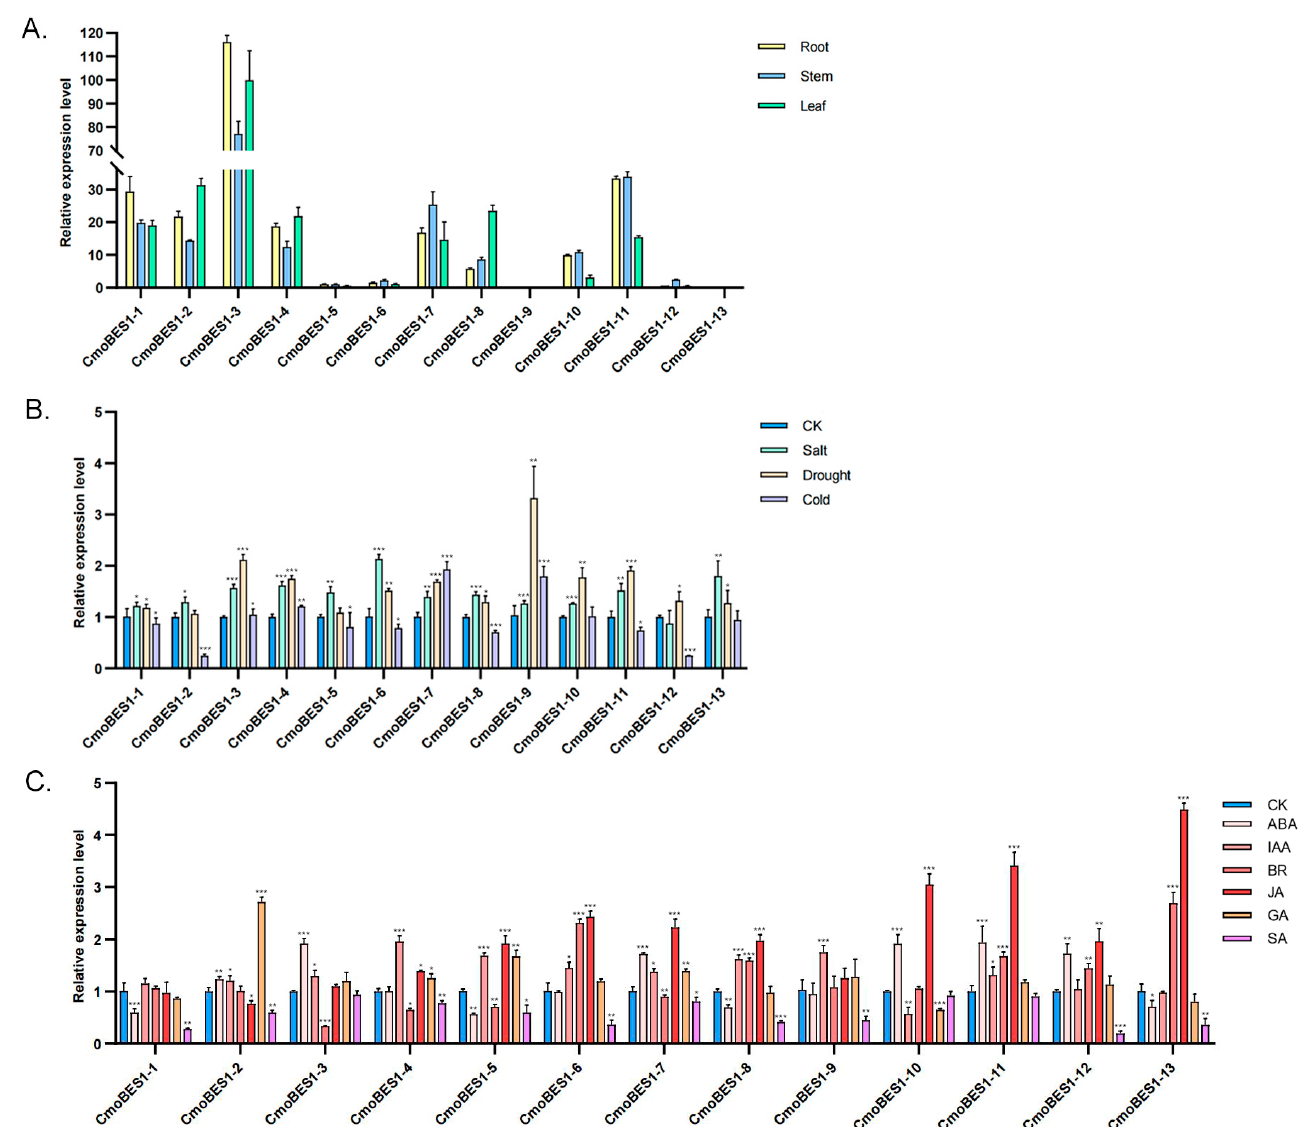
Figure 5. Expression patterns of 13 CmoBES1 genes in different tissues and under treatments. ( A ) The expression pattern of 13 CmoBES1 genes in roots, stems, and leaves. The expression of CmoBES1-5 in leaves was set as 1. The expression of other CmoBES1 genes were deduced with the expression of CmoBES1-5 in leaves. ( B ) Relative expression levels of 13 CmoBES1 genes under salt, drought, and cold treatments. ( C ) Relative expression levels of 13 CmoBES1 genes under ABA, IAA, BR, JA, GA, and SA treatments. The average threshold cycle of qPCR as File S1 shown. The determined expression levels of all genes were calculated by the 2 −∆∆ CT method. The expression of genes in CK (control group, Hoagland’s nutrient solution) was set as 1. The experimental information was described in the Materials and Methods Section 4.5. Error bars show the standard deviation of the three replicates, and the asterisk indicates a significant difference. (Student’s t -test; * p < 0.05; ** p < 0.01; *** p <